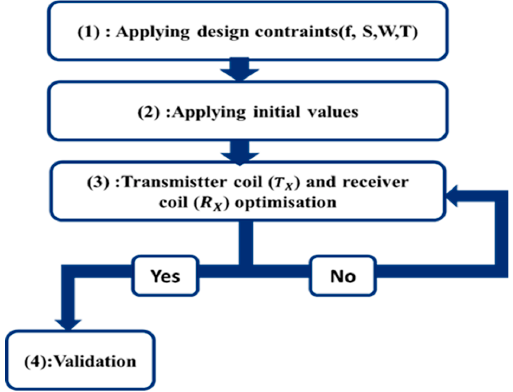
Figure 7. Followed steps to optimize the two coils.